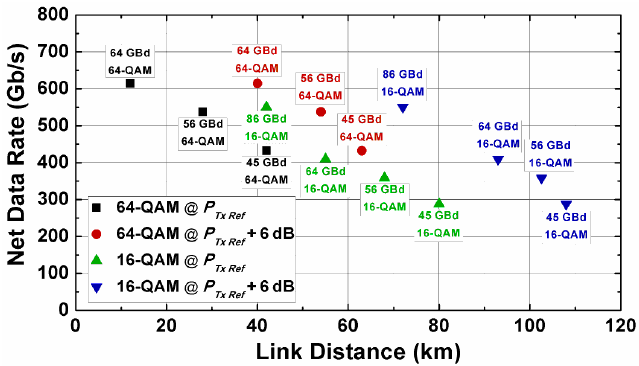
Figure 8. Net data rate as a function of transmission distance for 16-QAM and 64-QAM signals at various baud rates.